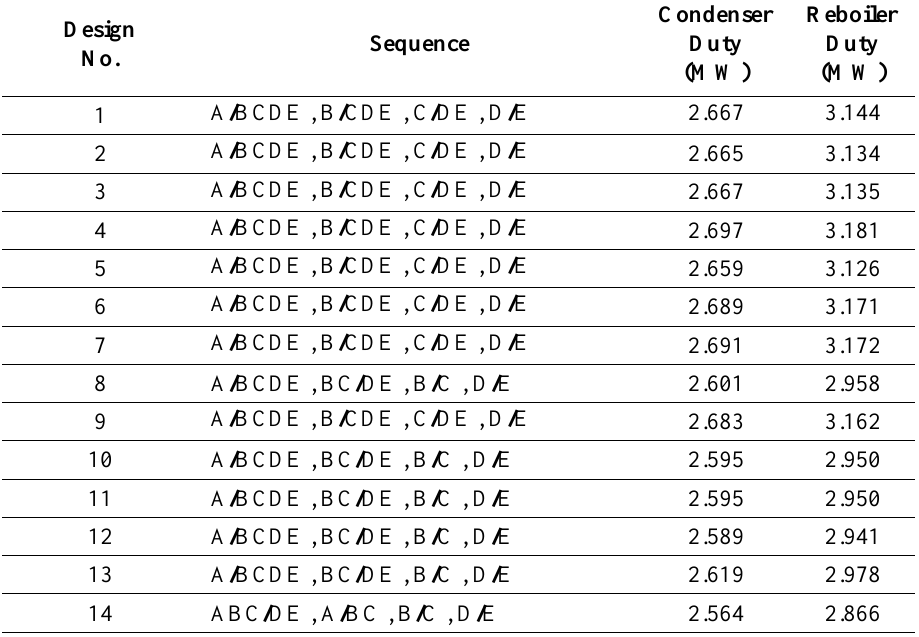
Table 9. Energy consumption at hot & cold utilities used to column